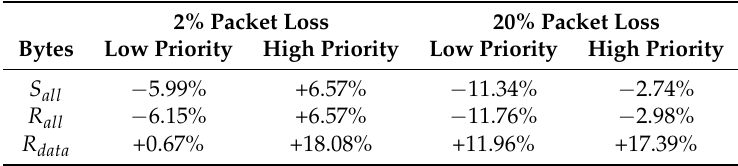
Table 12. Comparison of the two simulation modes for corner